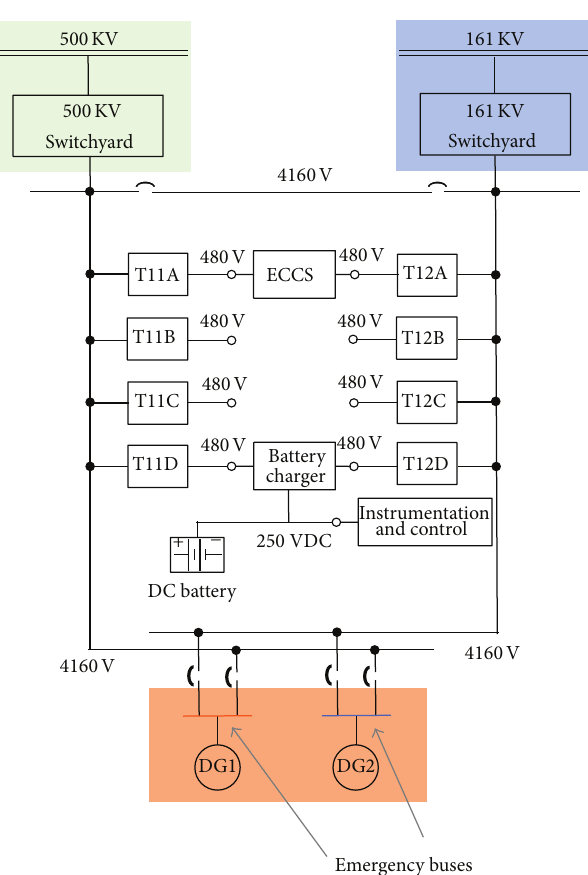
Figure 7: Scheme of the electrical system of the PWR